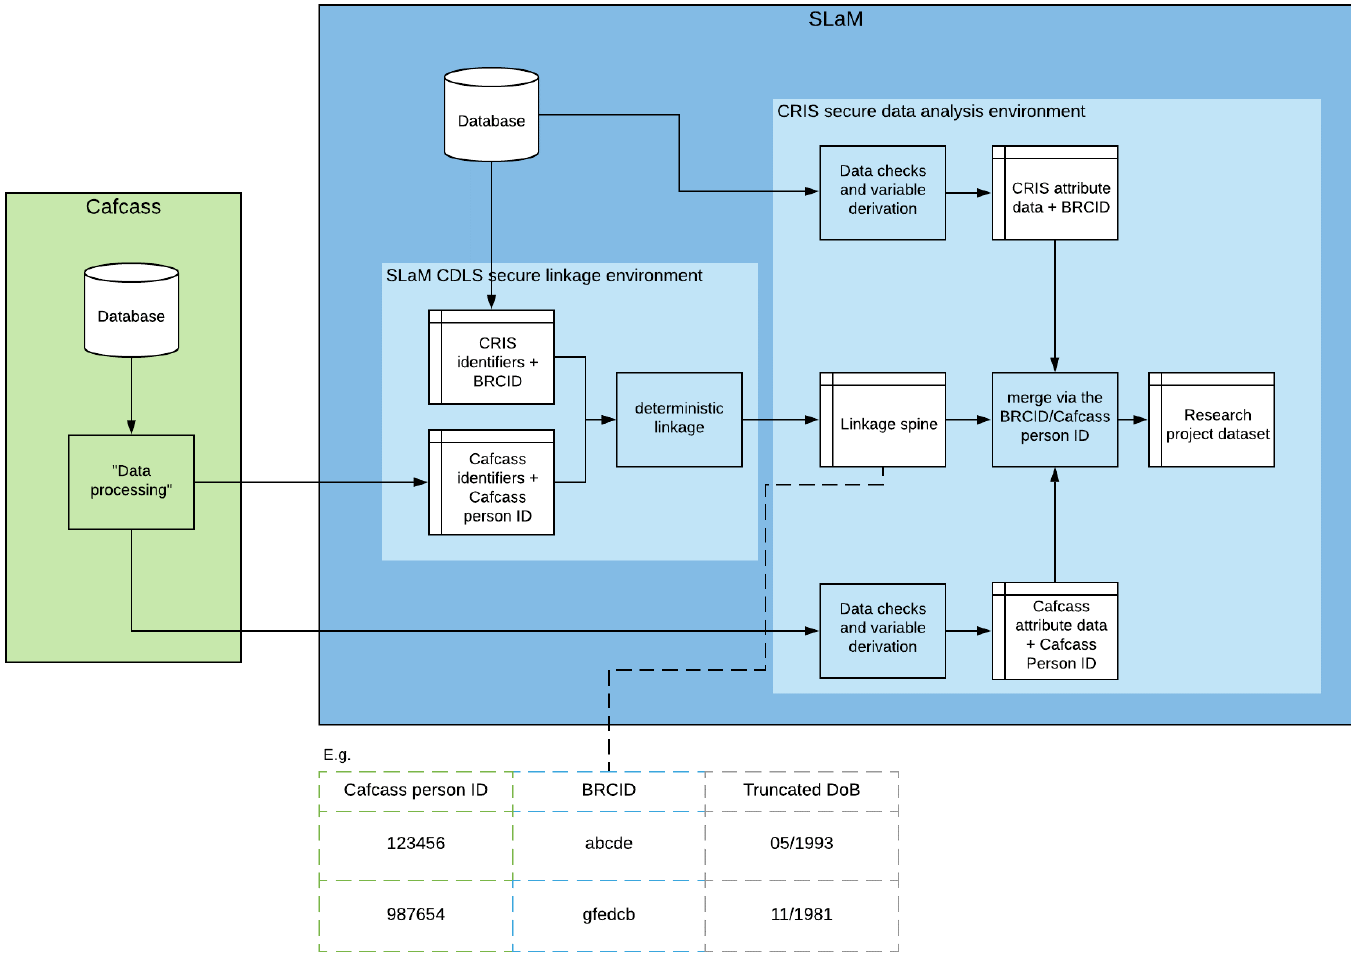
Figure 2: Cafcass-to-CRIS data linkage: applying the separation